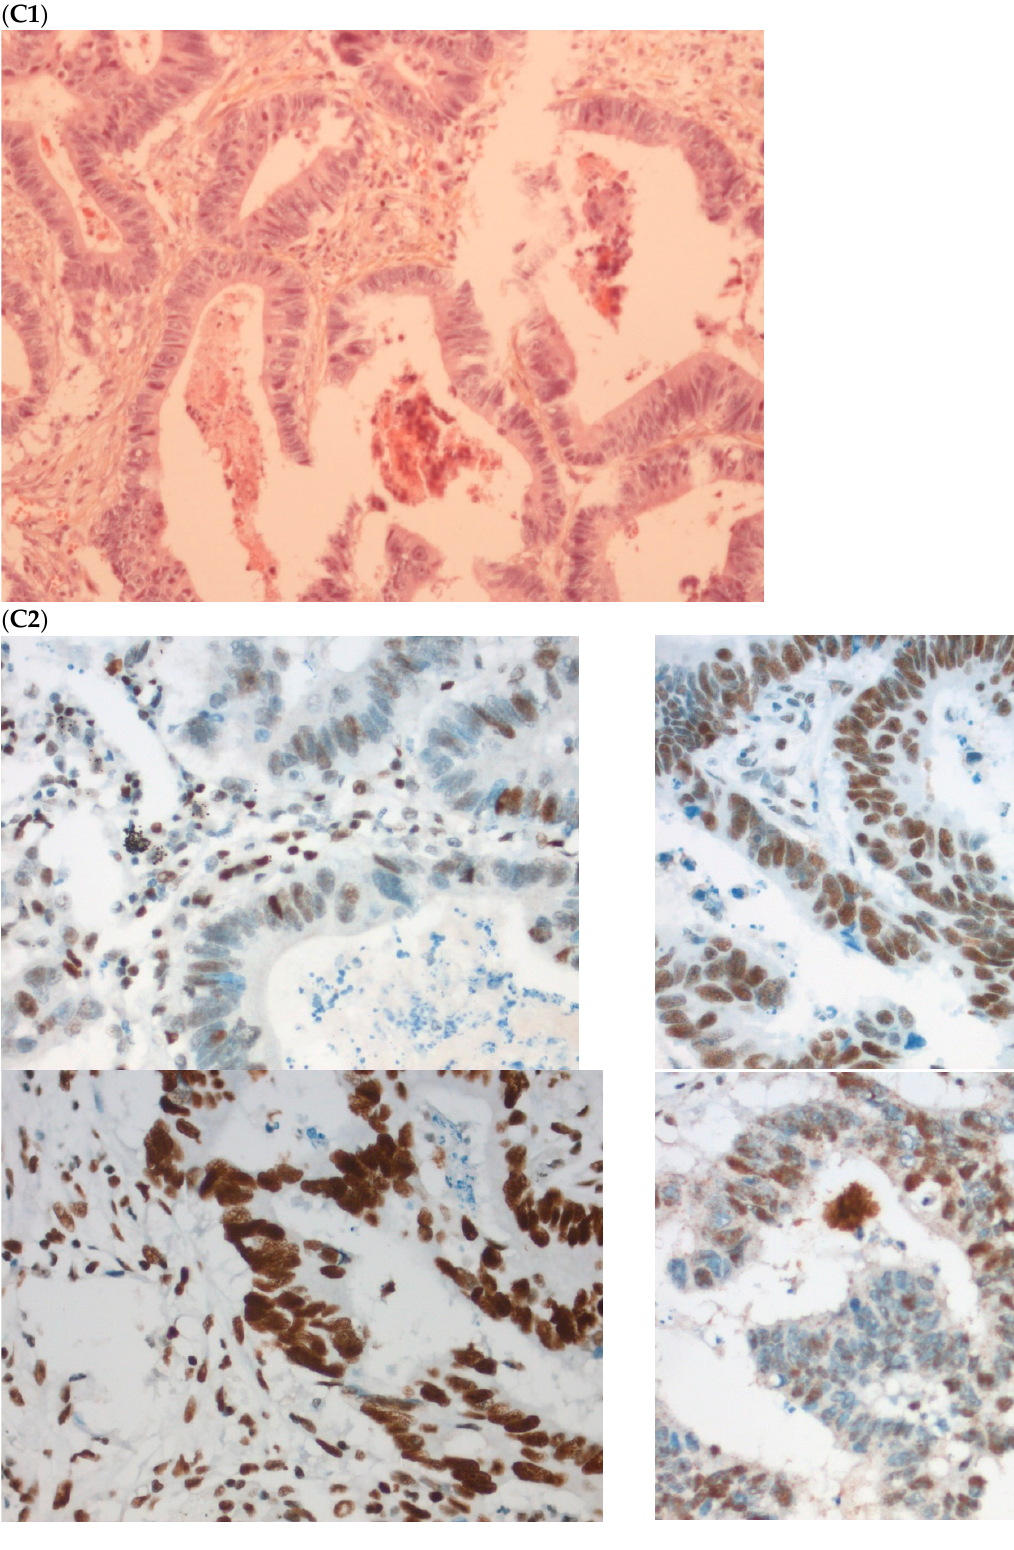
Figure 2. Pathological examination and MMR immunohistochemistry of the case number 1. ( A ) Pri- mary left-sided colon cancer in 2003 with pMMR status (( A1 ), hematoxylin and eosin stain, 100× magnification) with an expression of the four MMR proteins (400× magnification; ( A2 ) upper left: MLH1, upper right: MSH2, bottom left: MSH6 and bottom right: PMS2). ( B ). Primary right-sided colon cancer in 2005 with dMMR status (( B1 ), hematoxylin and eosin stain, 100× magnification) with a loss of MLH1 and PMS2 expression (( B2 ), upper left: MLH1 and upper right: PMS2) and MSH2 and MSH6 expression (bottom left: MSH2 and bottom right: MSH6). ( C ) Lung metastasis with